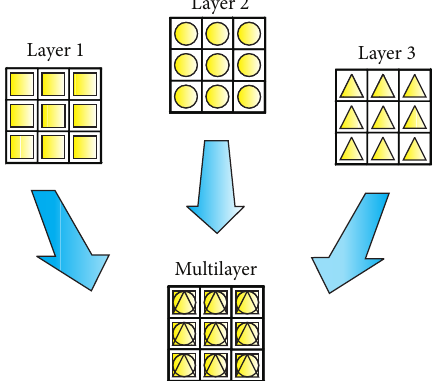
Figure 2: Assembling procedure for ESL